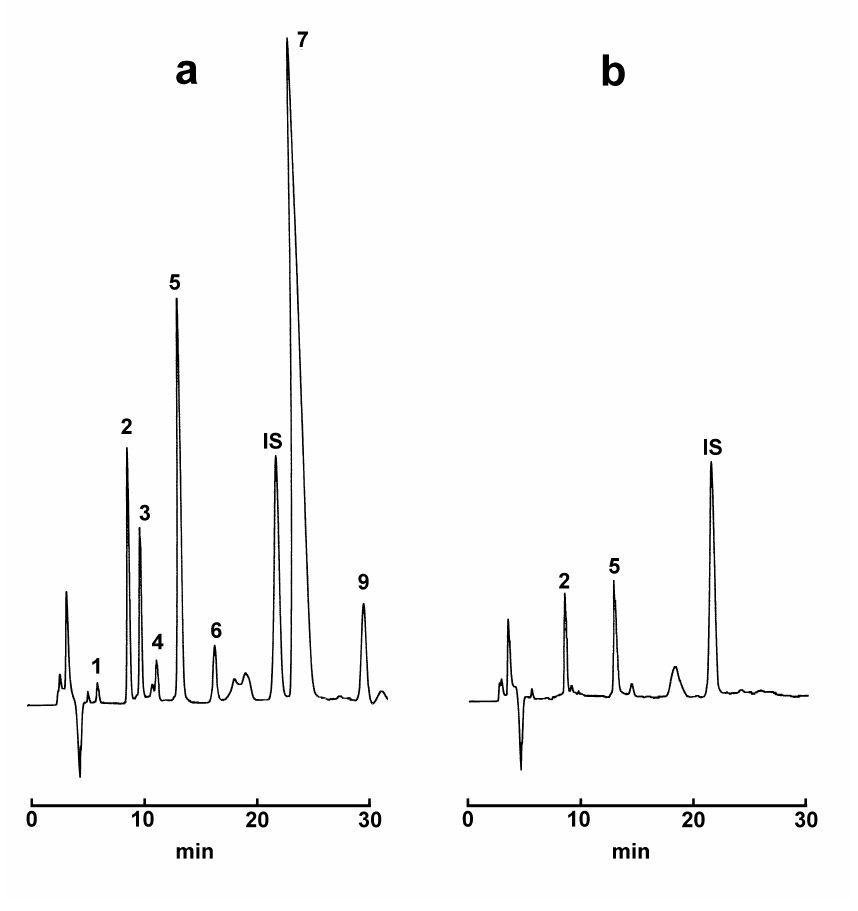
Fig. 4 Chromatograms for a 1:100 diluted photographic effluent sample before (a) and after (b) decomposition. IS – internal standard (MoO 2 − in Fig.